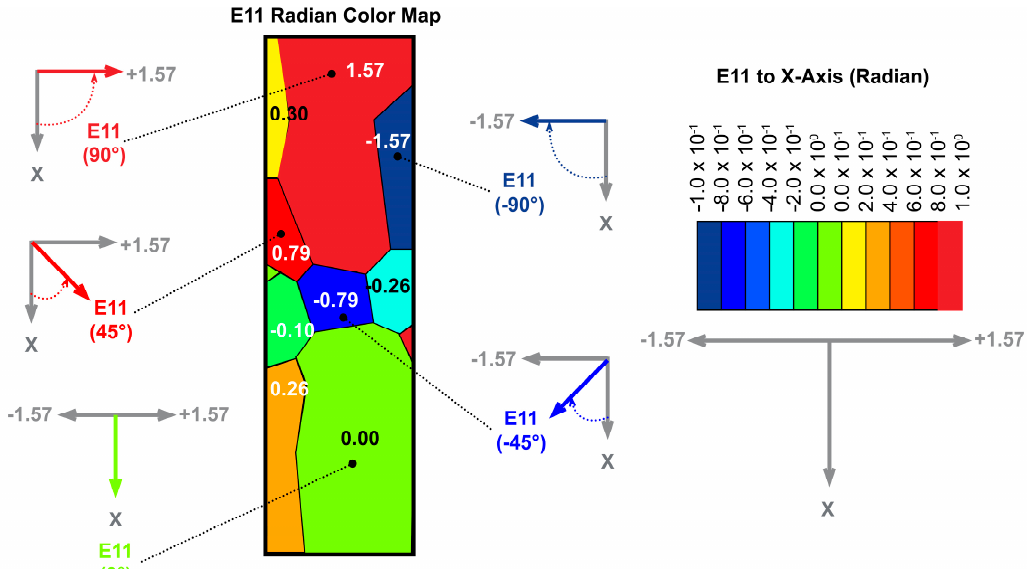
Figure 8. The random grain orientations via rotating the orthotropic elastic principal direction (E11) along the x-axis.